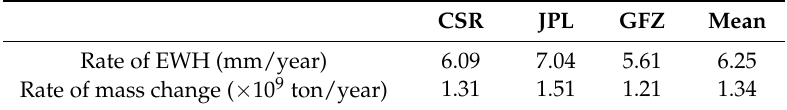
Table 2. GRACE-derived rate of EWH and the inferred rate of mass change over April 2002–March 2015 (156 months) in the dashed box defined in Figure 5 (note: one m 3 of water corresponds to one ton).